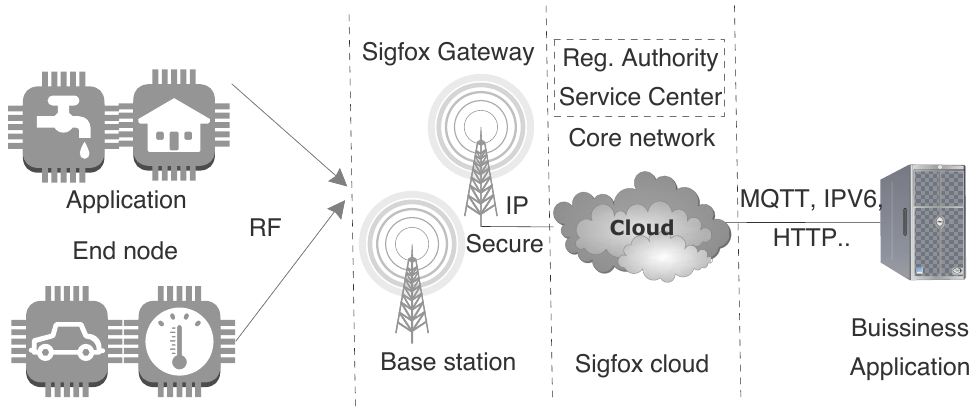
Figure 15. Sigfox network architecture.